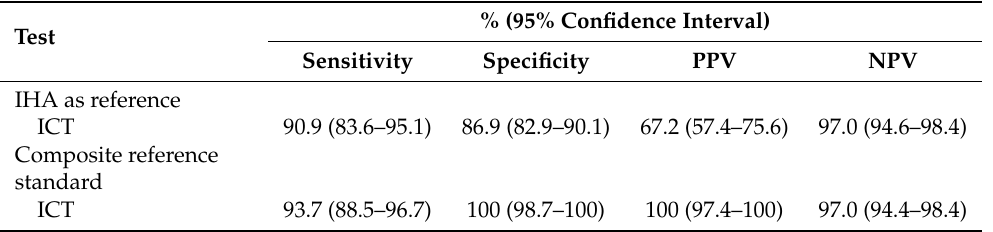
Table 4. Sensitivity, specificity, PPV and NPV of T. gondii diagnostic tests using a commercially available IHA and a composite reference standard as